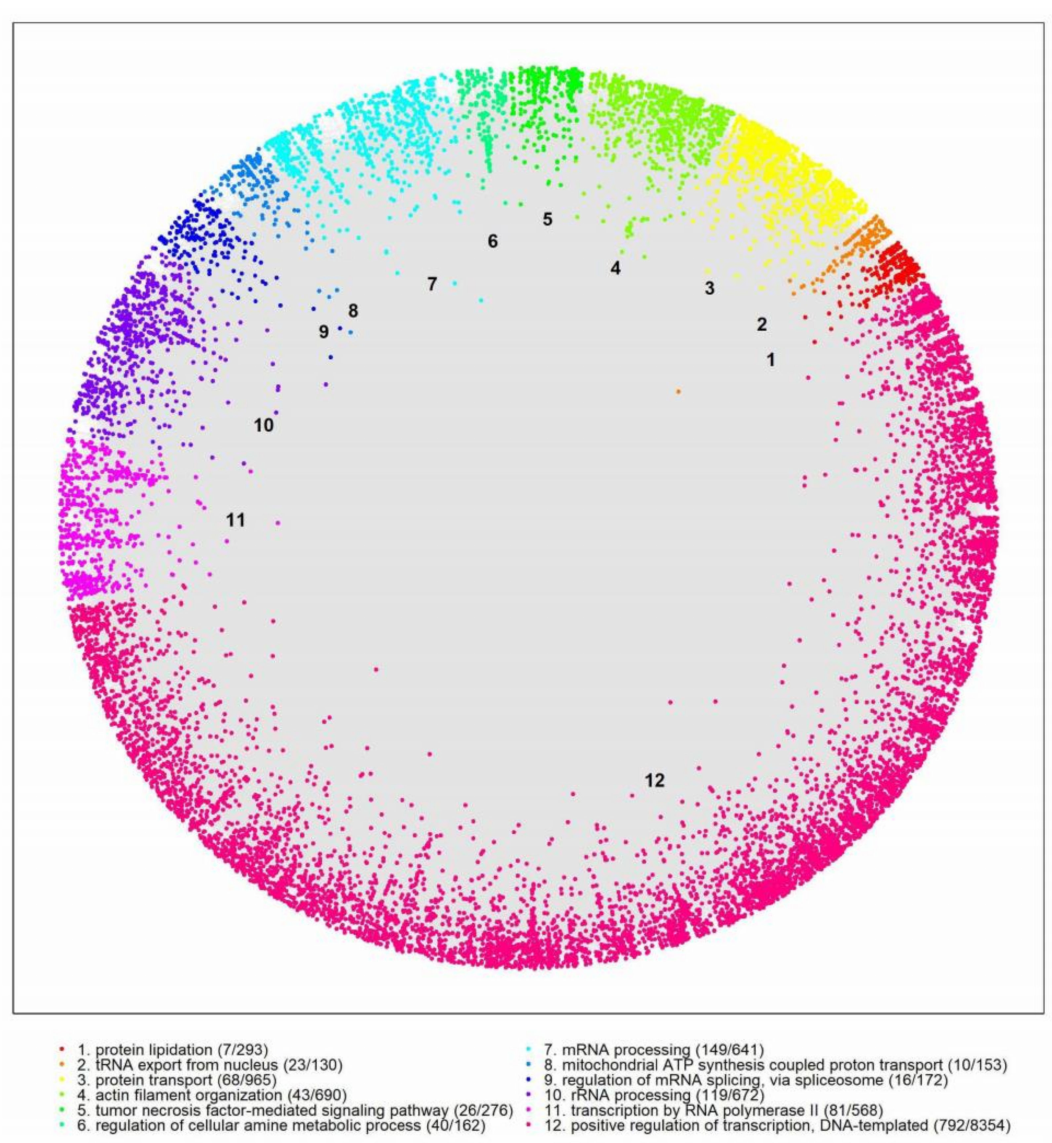
Figure 1. Human protein–protein interaction network embedded in the hyperbolic disc. Protein clusters in different colors were identified by big gaps separating groups of proteins in the angular dimension of the hyperbolic space. The overrepresented biological function in each cluster was determined via GO enrichment analysis (BP: Biological Process). Each cluster was assigned a numeric identifier (1–12). For each protein cluster, the number of proteins that are associated with the GO BP terms and the number of proteins in each cluster are